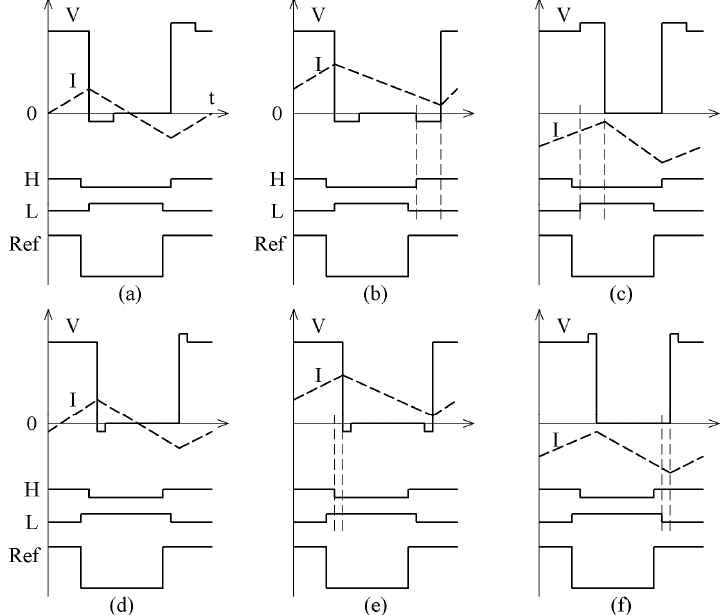
Figure 2. Output duty cycle for ( a ) discontinuous conduction mode (DCM) positive dead-time, ( b ) continuous conduction mode (CCM) current source positive dead-time, ( c ) CCM current sink positive dead-time, ( d ) DCM negative dead-time, ( e ) CCM current source negative dead-time, and ( f ) CCM